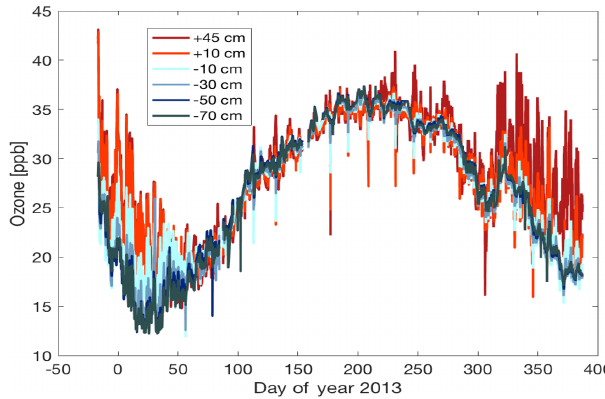
Figure 8. Ozone measured from the snow tower inlets throughout the year. Negative spikes in the data coincide with elevated NO x from exhaust infiltration in the